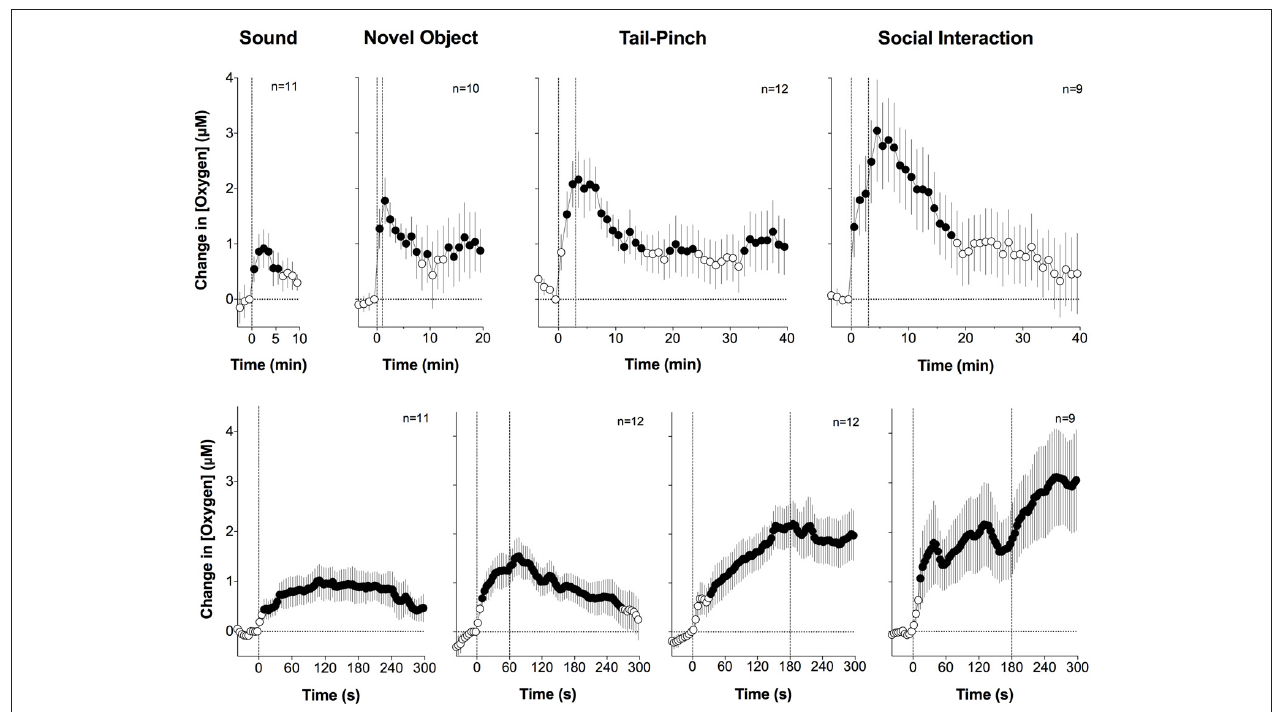
FIGURE 1 | Changes in nucleus accumbens (NAc) oxygen levels induced by arousing stimuli in freely-moving rats. Top graphs show mean ( ± SEM) changes relative to pre-stimulus baseline (= 0 µ M) analyzed with a slow, 1-min time resolution and bottom graphs show changes assessed at a high, 4-s time resolution. Values significantly different from pre-stimulus baseline ( p < 0.05, Fisher F-test) are shown as filled symbols. n indicates the number of averaged tests. The first dotted vertical line shows the stimulus onset, the second vertical line shows the stimulus offset. Original data were presented in Solis et al.